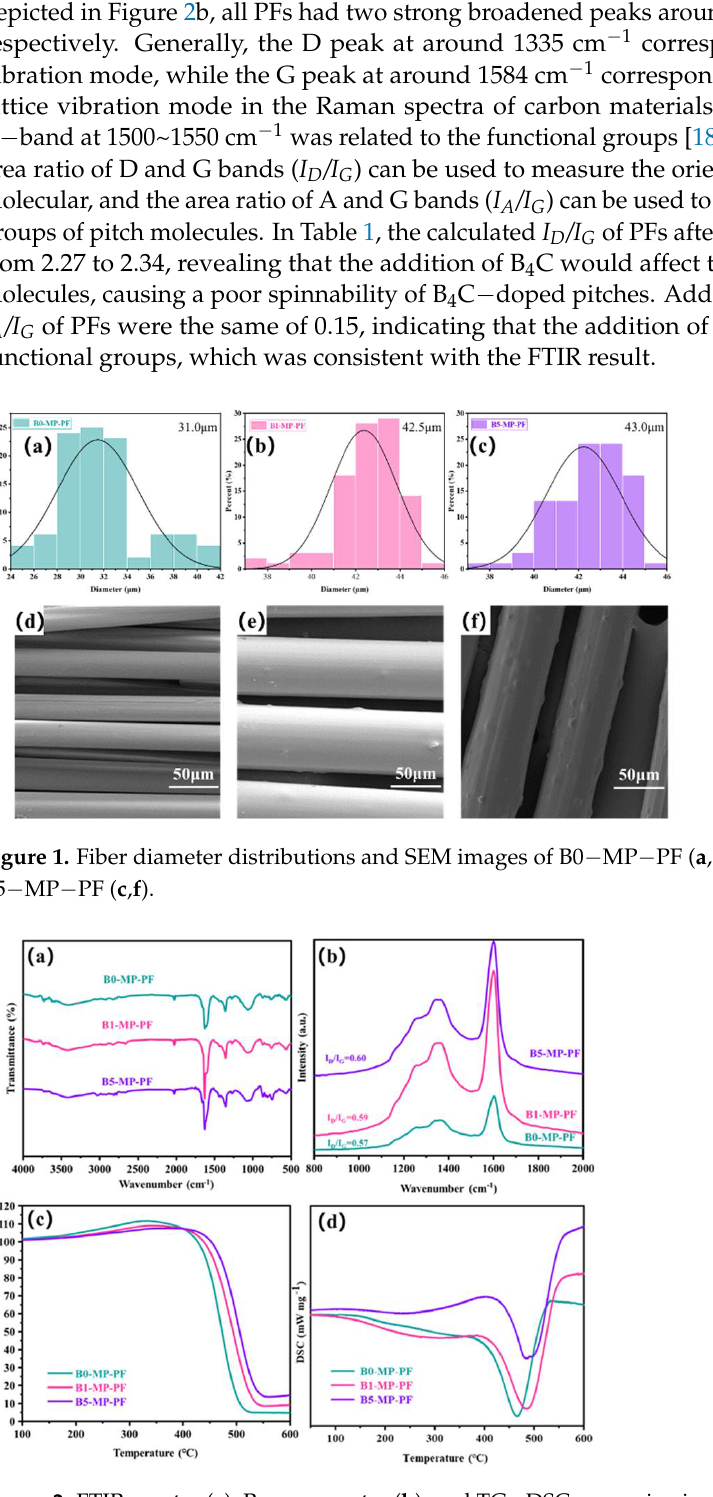
Figure 2. FTIR spectra ( a ), Raman spectra ( b ), and TG−DSC curves in air mood ( c , d ) of B0−MP−PF, B1−MP−PF and B5−MP−PF. Table 1. General properties of PFs, SFs and CFs.